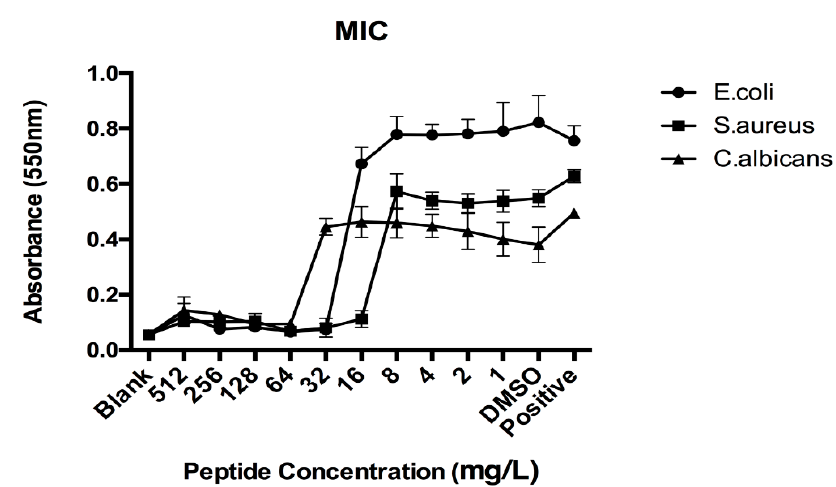
Figure 2. Minimal inhibitory concentration (MIC) curves obtained following incubation of synthetic LFB with Escherichia coli (NCTC 10418), Staphylococcus aureus (NCTC 10788) and Candida albicans (NCPF